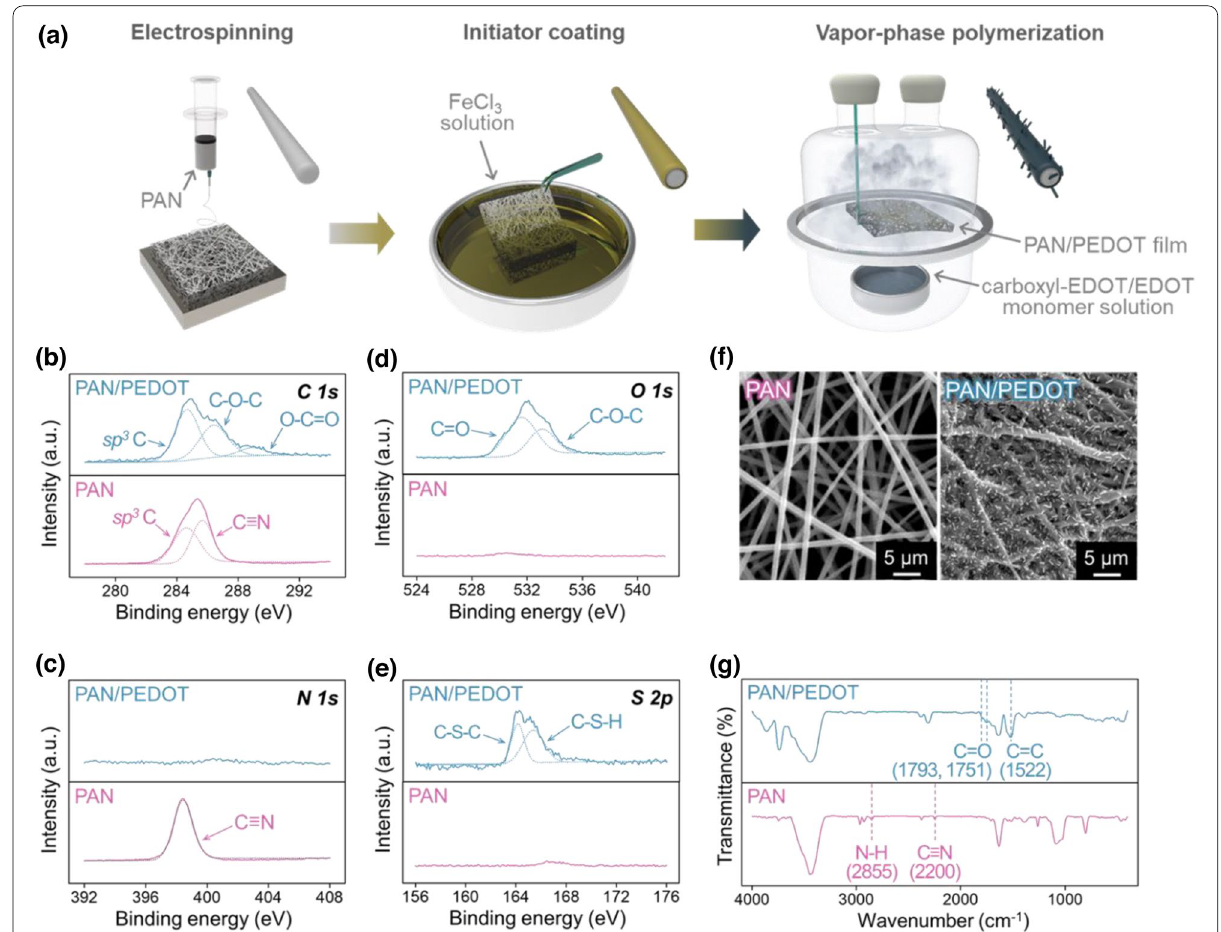
Fig. 1 Fabrication of the carboxyl-functionalized PAN/PEDOT nanohybrids. a Schematic illustration of the nanofiber fabrication process. b C 1s, c N 1s, d O 1s and e S 2p spectra of the PAN nanofiber and PAN/PEDOT nanohybrids. f SEM image of the pristine PAN nanofiber and the